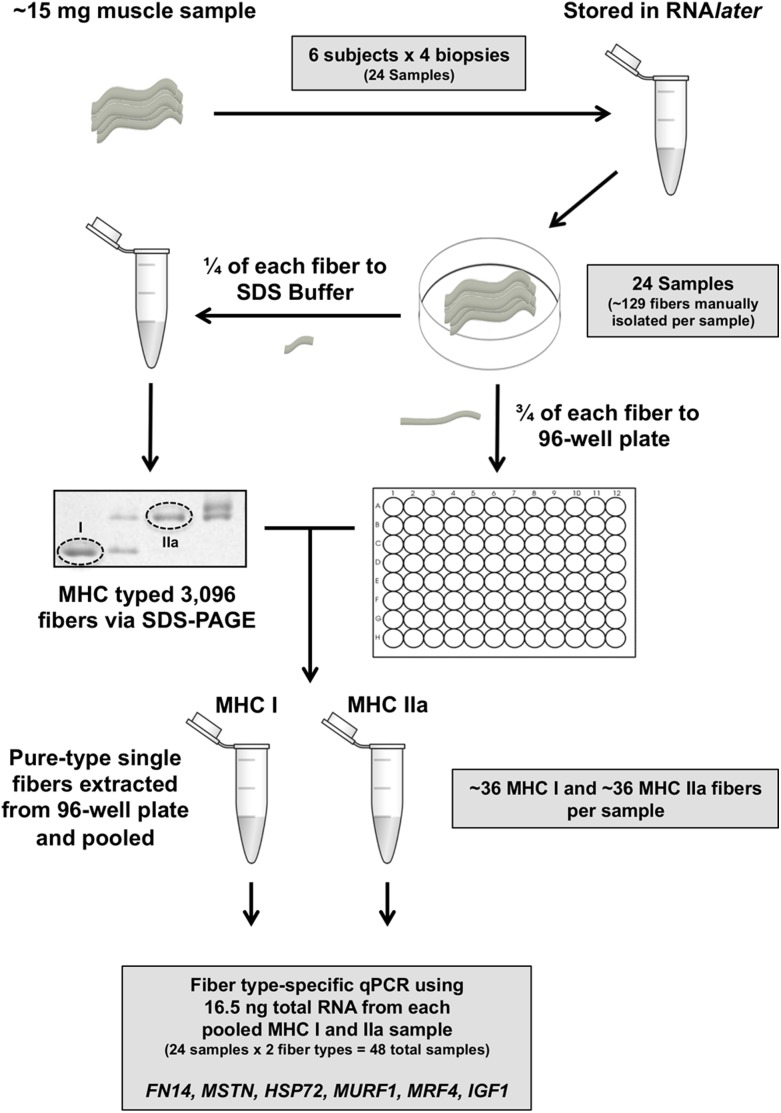
Schematic of method used to conduct fiber type-specific isolation of single muscle fibers for qPCR analysis.